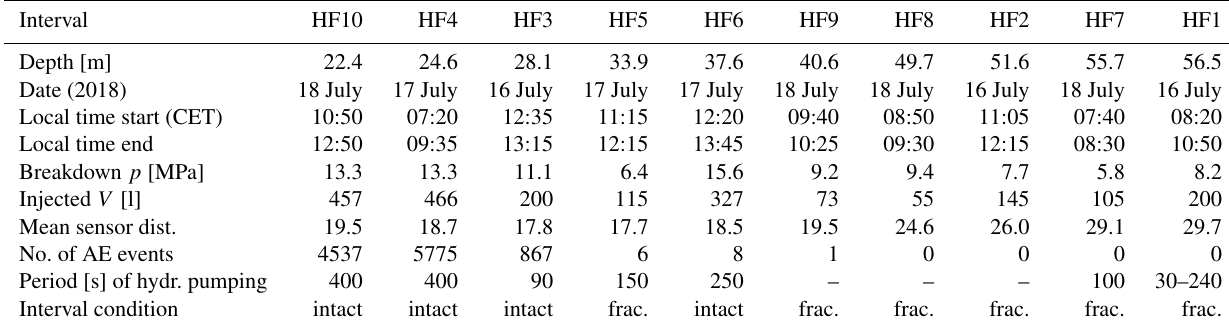
Interval condition